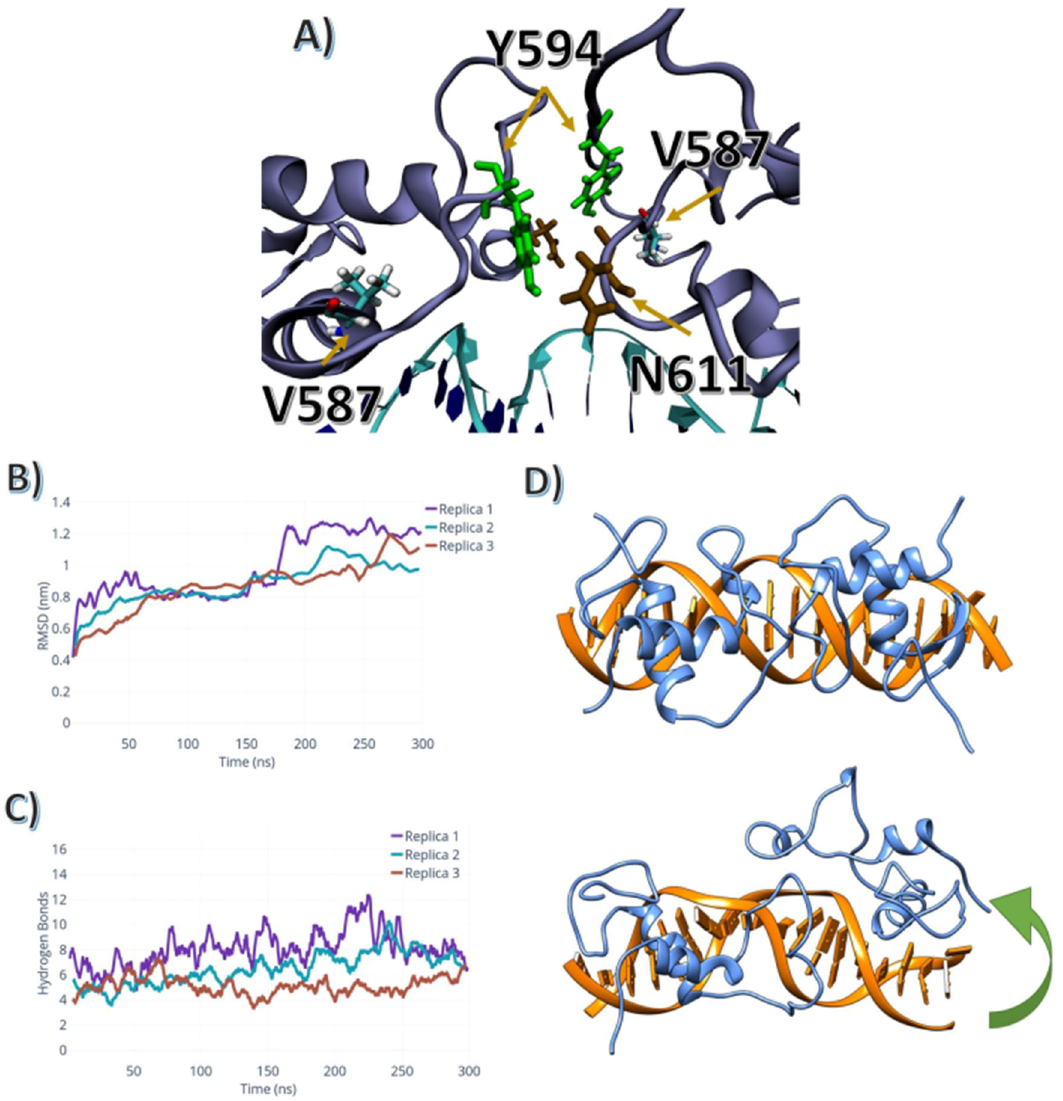
Figure 4. V587 and A588S mutation conformational changes: ( A ) V587 affects the dynamics of both N611 (brown) and Y594 (green). ( B ) RMSD for the A588S mutation simulations. ( C ) Total number of hydrogen bonds between the ARE and the AR-DBD for the A588S mutant. ( D ) The A588S mutant twist movement; the AR-DBD (blue) and the DNA-ARE (orange); The green arrow indicates the twist motion which the homodimer containing the A588S mutation undergoes.